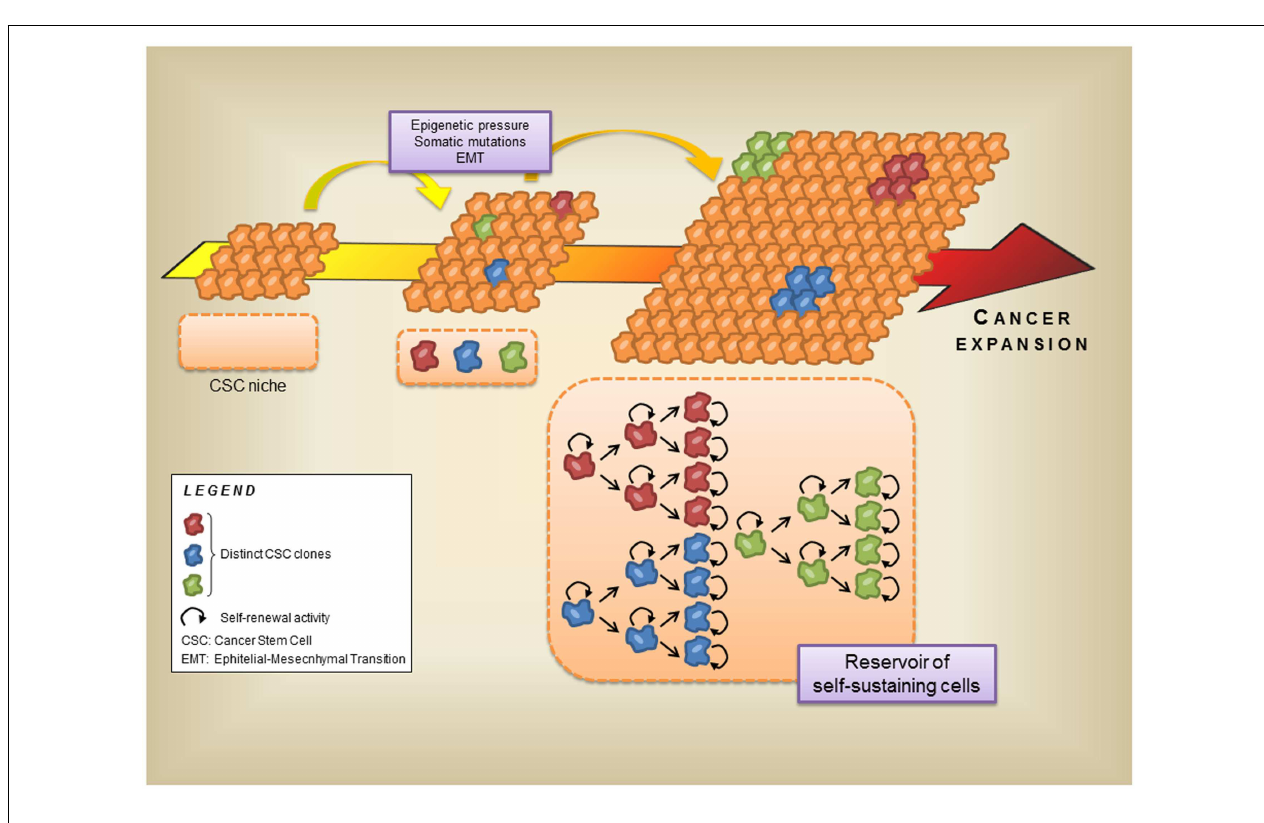
and enrich the cancer stem cell niche. During the late stages of tumor progression these stem cell clones sustain the cancer expansion with their self-renewal ability.Thus, the cancer stem cell niche can also be regarded as a reservoir of self-sustaining cells for the tumor